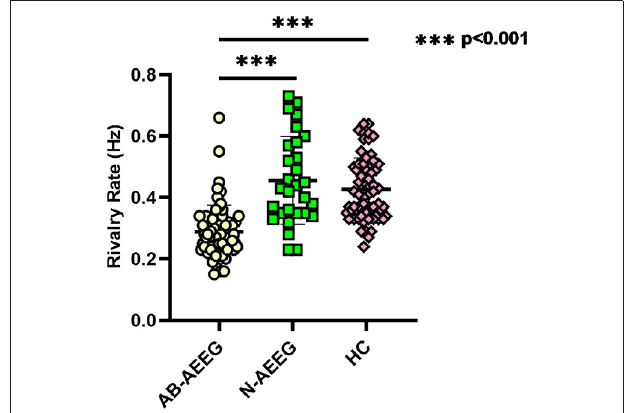
FIGURE 2 | Scatter diagram of rivalry rates for AB-AEEG, N-AEEG and HC. AB-AEEG, abnormal ambulatory electroencephalogram; N-AEEG, normal ambulatory electroencephalogram; HC, healthy control; One-way ANOVA demonstrated a statistical difference in alternation rate among the HC, AB-AEEG, and N-AEEG groups ( F = 44.962, p = 0.000). BR alternation rate was significantly slower in the AB-AEEG group compared to the N-AEEG